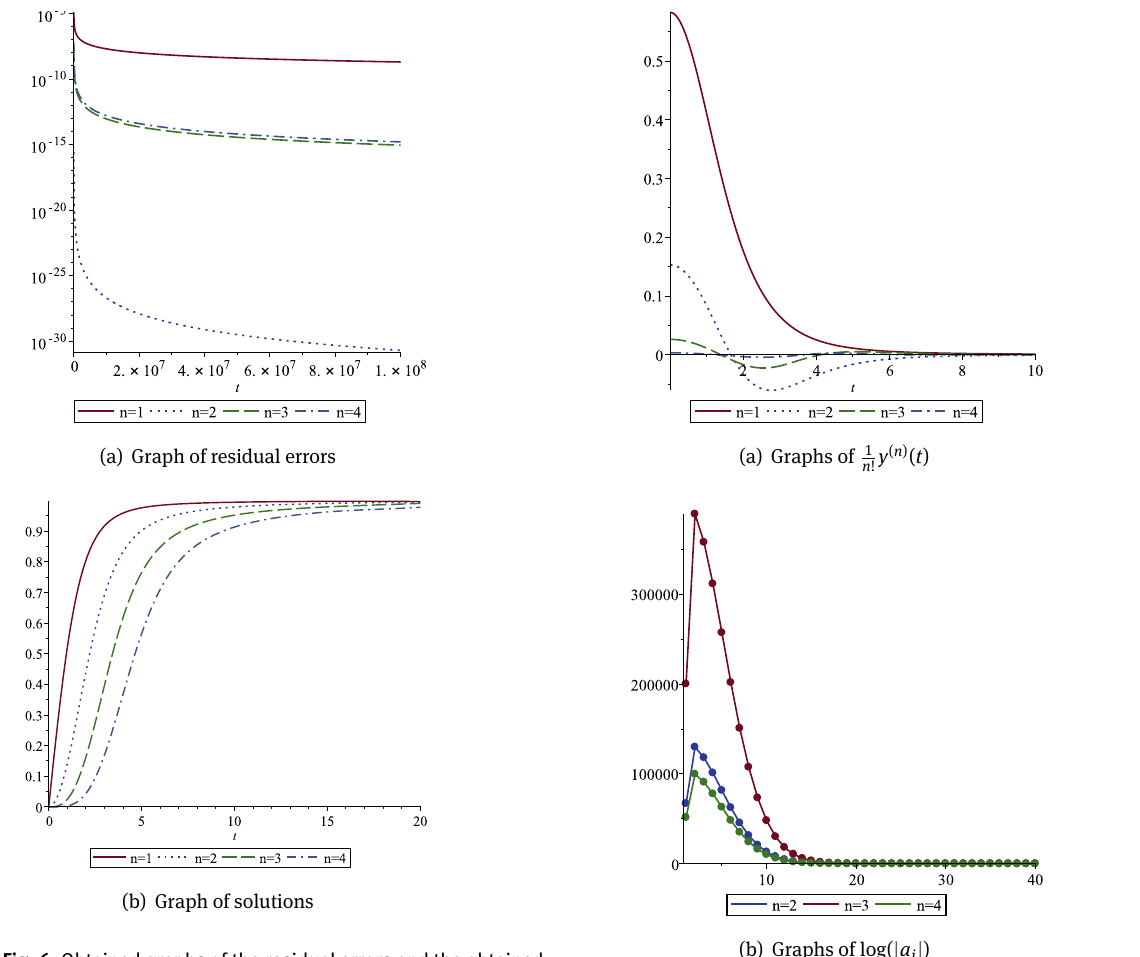
Fig. 6: Obtained graphs of the residual errors and the obtained solutions for various values of n .